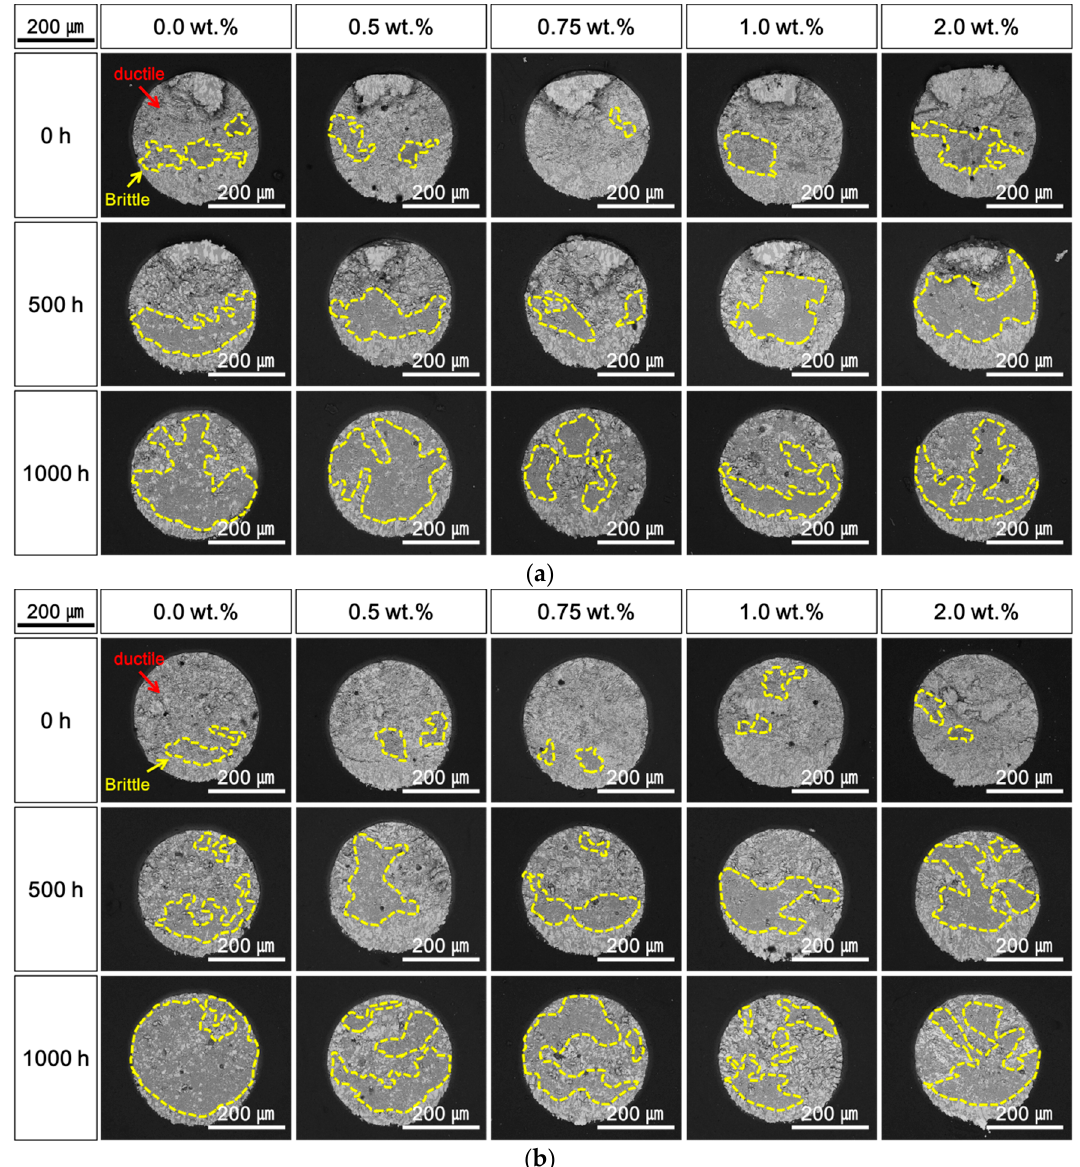
Figure 10. Top-view scanning electron microscopy (SEM) micrographs of fracture surfaces after a high-temperature storage (HTS) test at 115 °C: ( a ) 0.1 m/s and ( b ) 1.0 m/s.